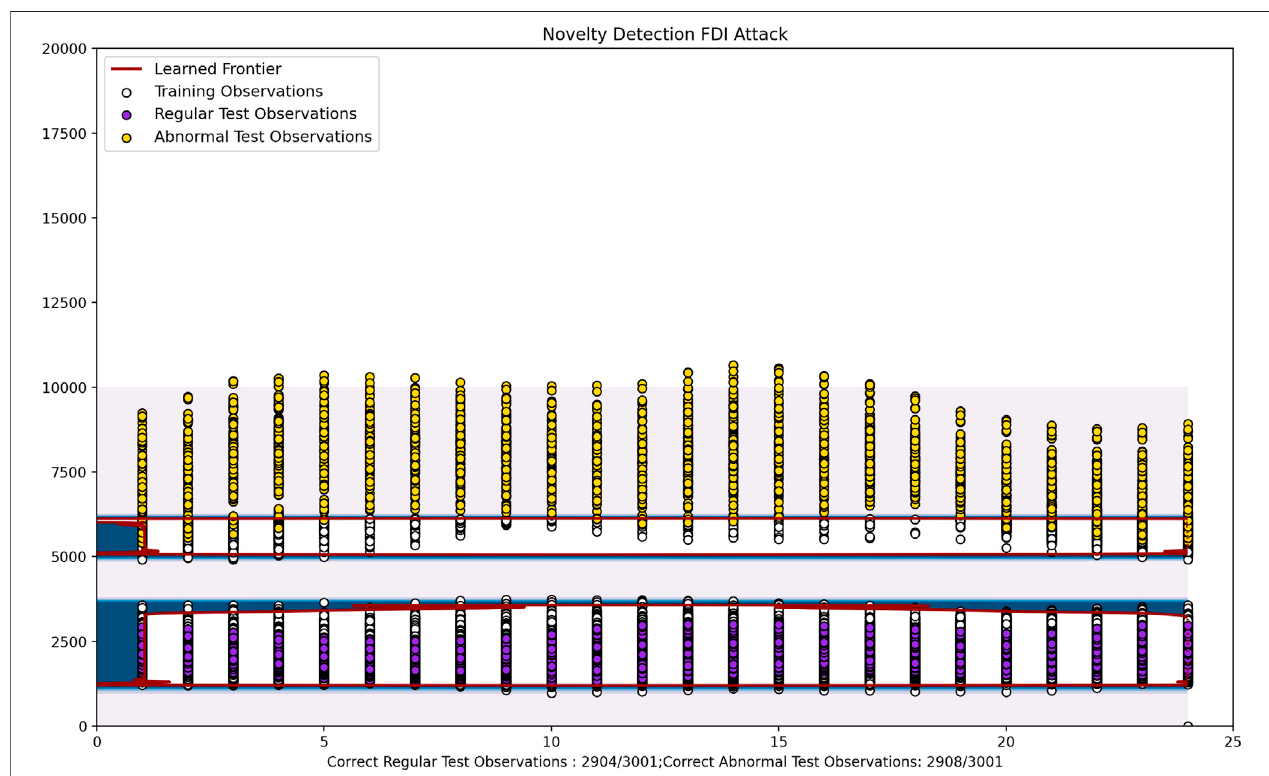
FIGURE 12 | OC-SVM on fi rst